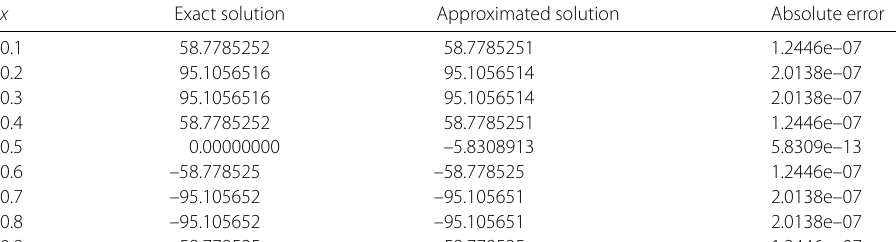
Table 7 A comparison of exact values and approximated values at different knots at time T = 10 x